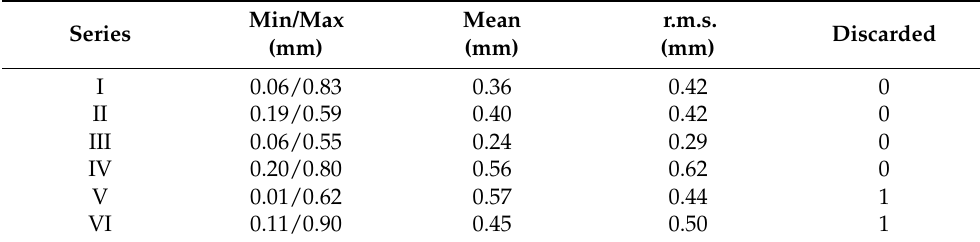
Table 5. Segmentation error on volunteers.